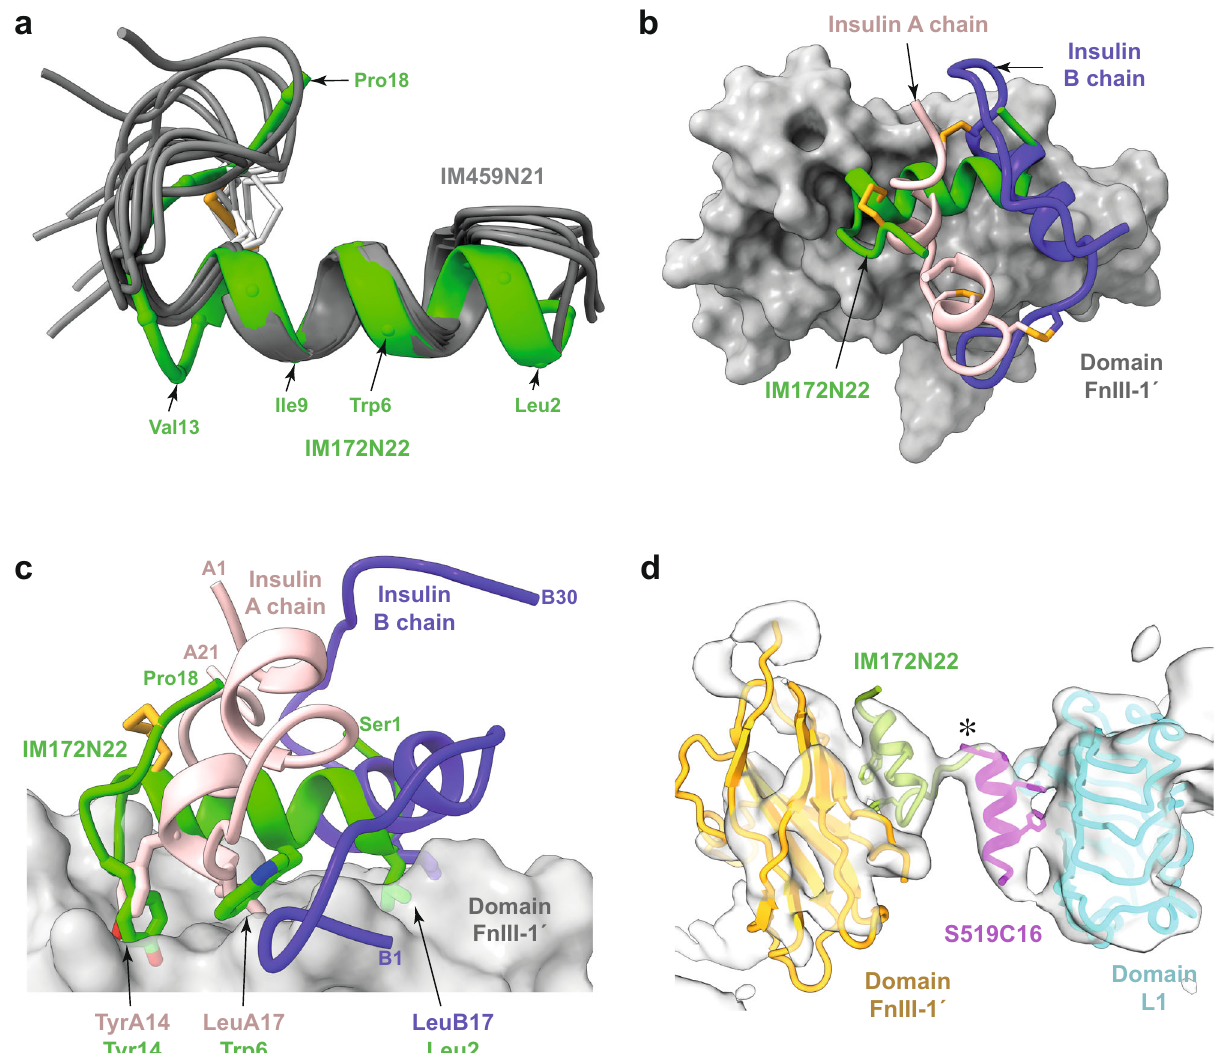
Fig.4|IM459N21solutionstructureandcomparisonofthemodesofbindingof IM172N22 and insulin. a Correspondence of the backbone conformation of the hIR-bound IM172N22 peptide (green) with that of IM459N21 peptide (grey) deter- mined in solution (for clarity, only six of the NMR-based IM459N21 models are shown). The orange bonds depict the IM172N22 cysteine residues and their asso- ciated disul fi de bond; the white bonds depict those of IM459N21. Selected IM172N22 residues are labelled. b Overlay of the structure of IM172N22 (green) boundtodomainFnIII-1 ′ (grey)withthatofinsulin(Achainpink,Bchaindarkblue) bound to the same domain (PDB 6SOF) 5 . The orange bonds depict the disul fi de Such reduced signalling output aligns with the EC 50 s reported in Fig. 1c. The structural reasons for [Site 2]-[Site 1]-peptides not being able to induce a fully activated ( “ legs-together ” ) conformation most likelyresultfromtheconstituentdomainsofthereceptor[L2-(FnIII-1)] 2 head module being cross-linked differently by these peptides (Fig. 2g) in comparison to that by insulin (Fig. 2e). hIR thus appears to be molecule capable of being stabilised in a variety of conformations that in turn determine signalling ef fi ciency.